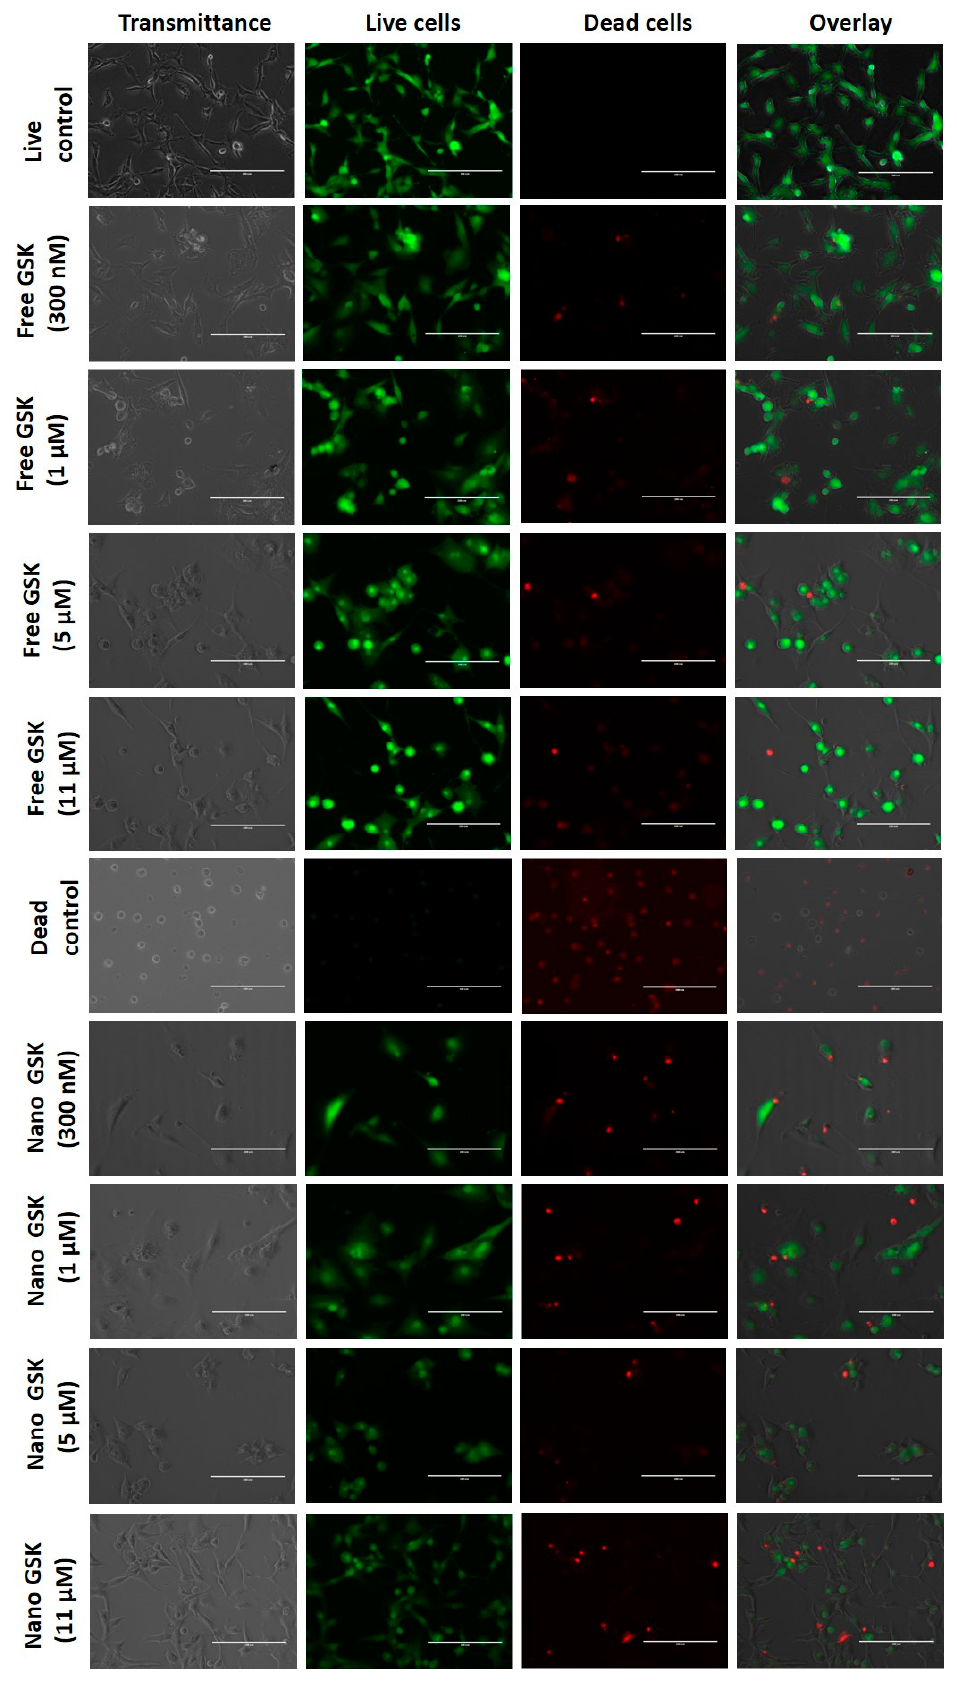
Figure 6. Live-Dead images of U87-MG cells treated with different concentrations of free and nano GSK. Images captured under transmittance, GFP (Live) and RFP filter (Dead) are indicated.